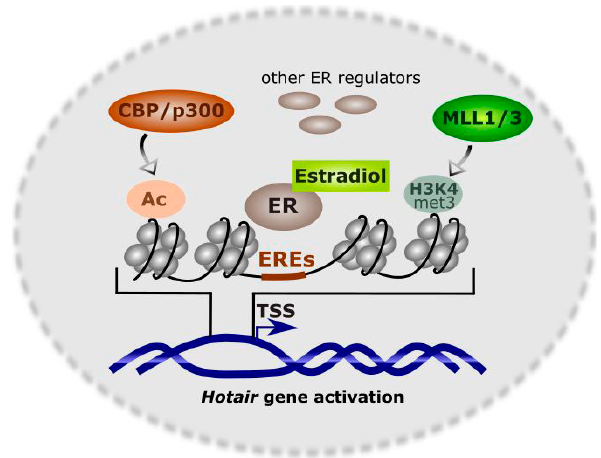
Figure 3. Transcriptional regulation of HOTAIR in the presence of estradiol. Several estrogen receptors (ERs) and their coregulators can bind the HOTAIR promoter, including the mixed lineage leukemia (MLL) family of histone methyl-transferases MLL1 and MLL3, histone acetyl-transferases CBP (cAMP response element-binding protein)/p300, and other proteins. Their action results in trimethylation of histone H3 at lysine 4 (H3K4met3) and histone tails acetylation (Ac) associated with trans-activation of HOTAIR. EREs–estrogen response elements, TSS–transcription start site.